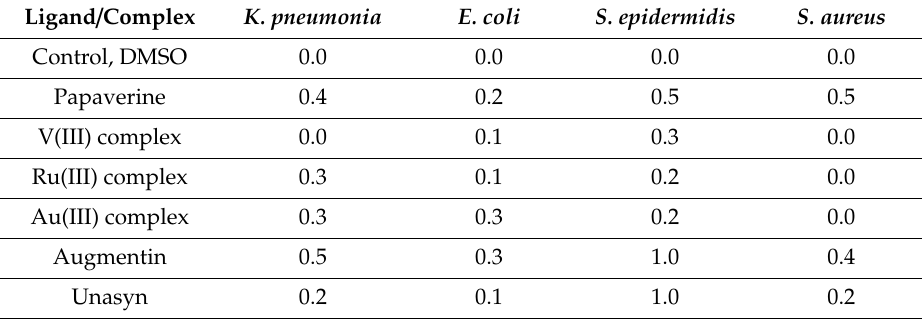
Table 6. Antibacterial activities (inhibition zone diameter, mm / µ g sample) of papaverine and its metal